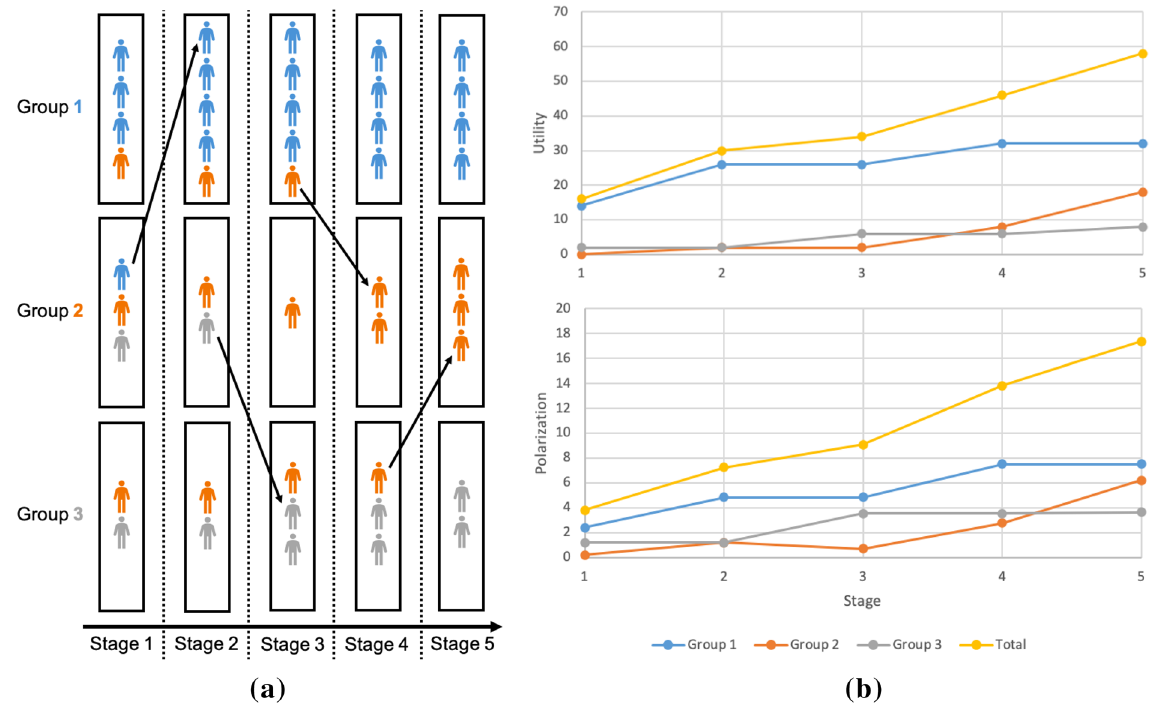
Figure 1. Example of group dynamics with polarization and utility growth over time. ( a ) Evolution of group memberships, with three potential groups and nine different participants. These individuals hold three different stances (each marked by its own color, either blue, orange, or grey) for some arbitrary attribute. ( b ) The increase of group utility and group polarization in discrete steps as the members of the example groups change membership to maximize their utility. All steps made are egocentric and altruistic.